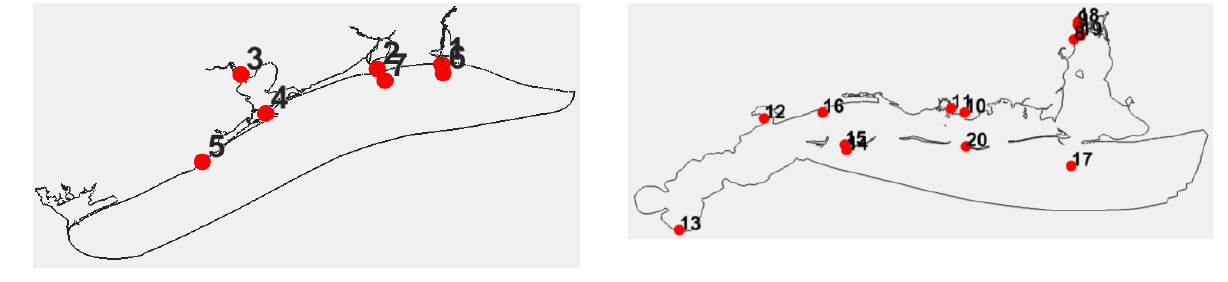
Figure 15. Station location maps for temperature skill assessment comparison between nested NGOFS and NGOFS.